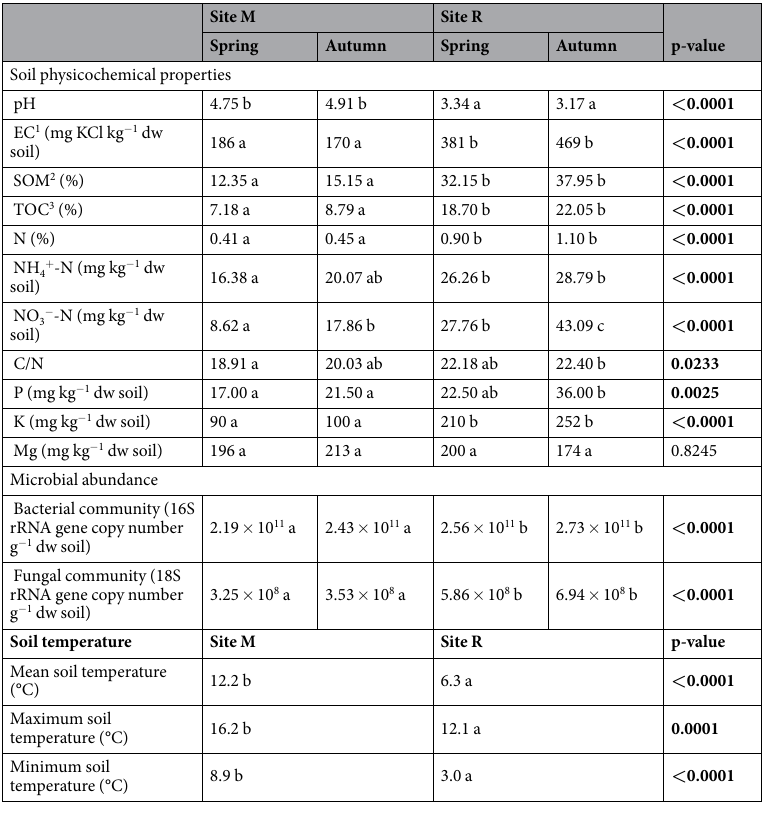
Table 1. Soil physicochemical properties, bacterial and fungal abundances and soil temperature measurements determined at the deciduous forest site M (545–570 m asl) and the coniferous forest site R (1,724–1,737 m) in spring and autumn. For ANOVA analyses, p-values in bold denote statistical significance (p ≤ 0.05); for Tukey’s HSD tests, values followed by different letters are significantly different (p ≤ 0.05). 1 EC, electrical conductivity. 2 SOM, soil organic matter. 3 TOC, total organic